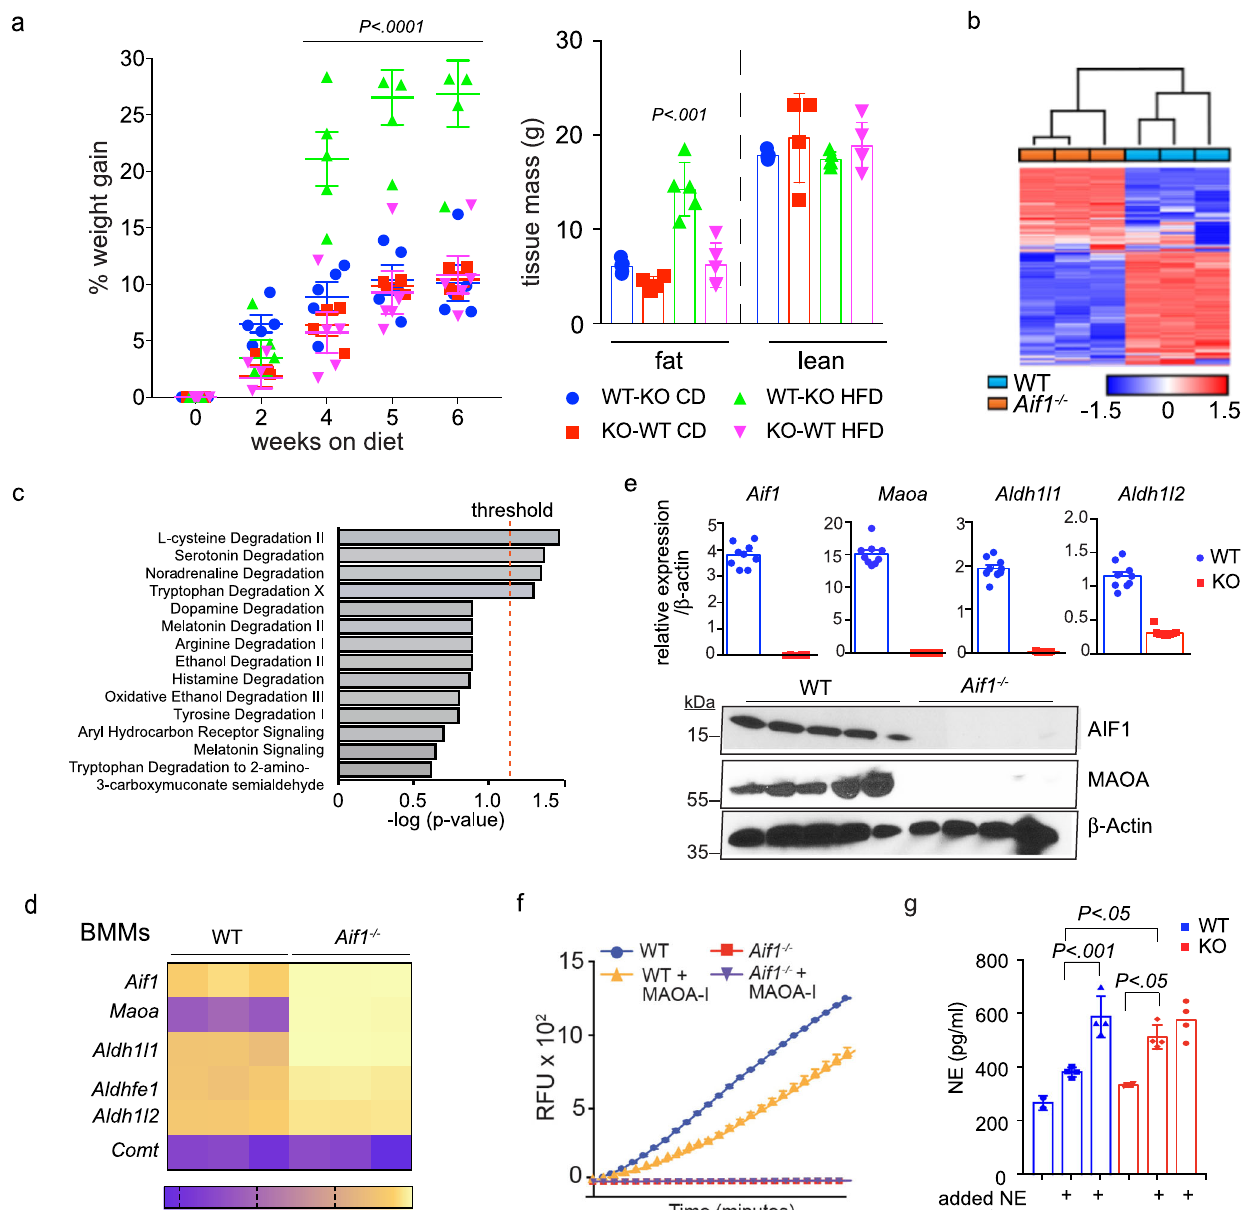
Fig.4|AIF1expressioninbonemarrow-derivedcellsaffectsobesityresistance. a Total bone marrow cells from WT or Aif1 − / − donor mice (age 6 – 8 weeks)